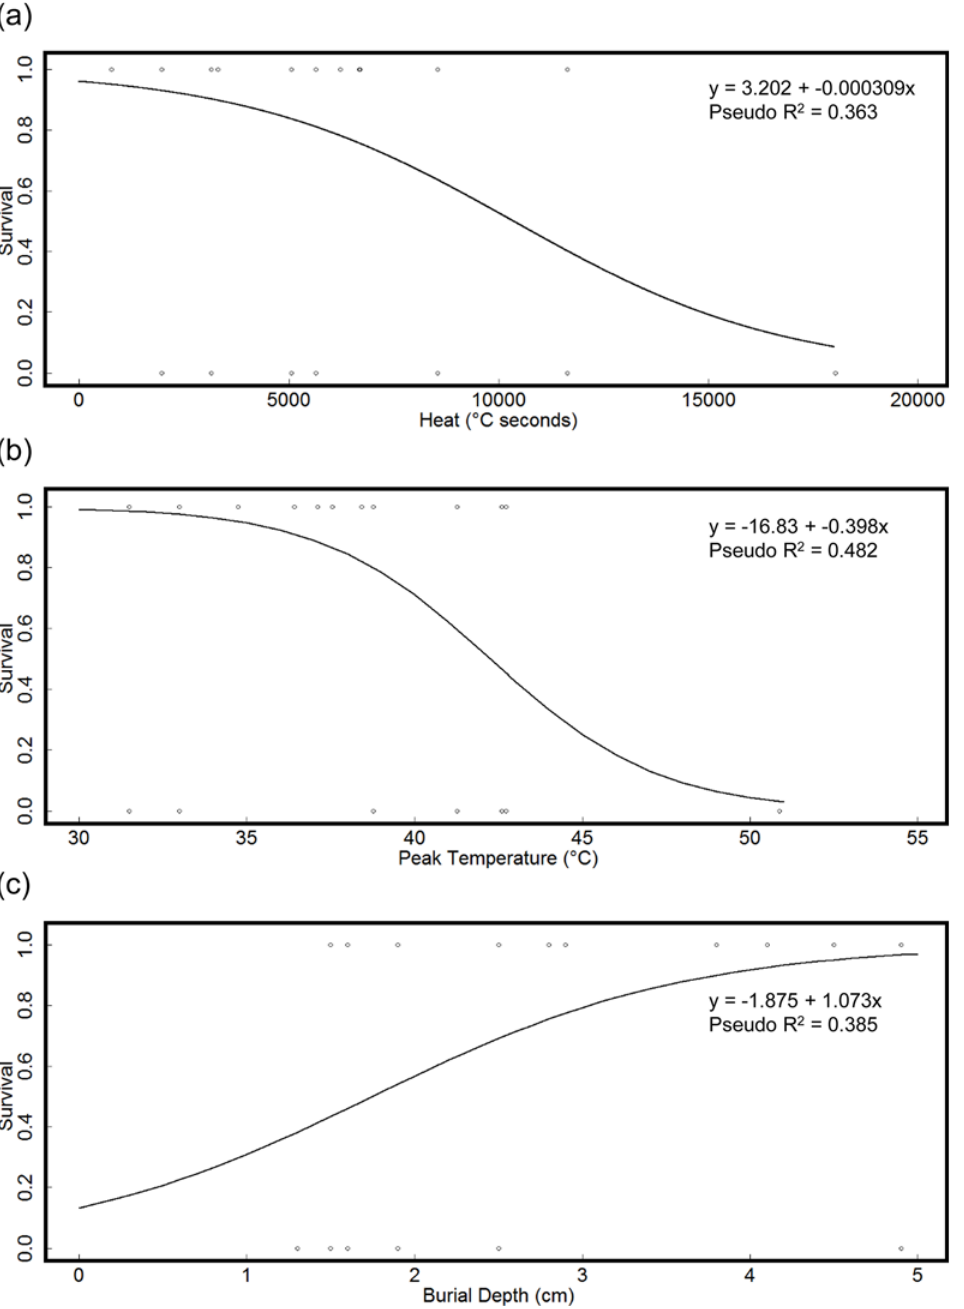
Fig 6. Probability of survival of E . atala pupa following controlled burning. Plot of survival probability of E . atala pupae to successful adult eclosion as a function of heat (a), peak temperature (b), and burial depth (c) from prescribed burning July 5-6 th , 2012 at the Ordway Swisher Biological Station, Melrose, Florida. Nagelkurke/Cragg & Uhler ’ s pseudo R 2 included as measure of model